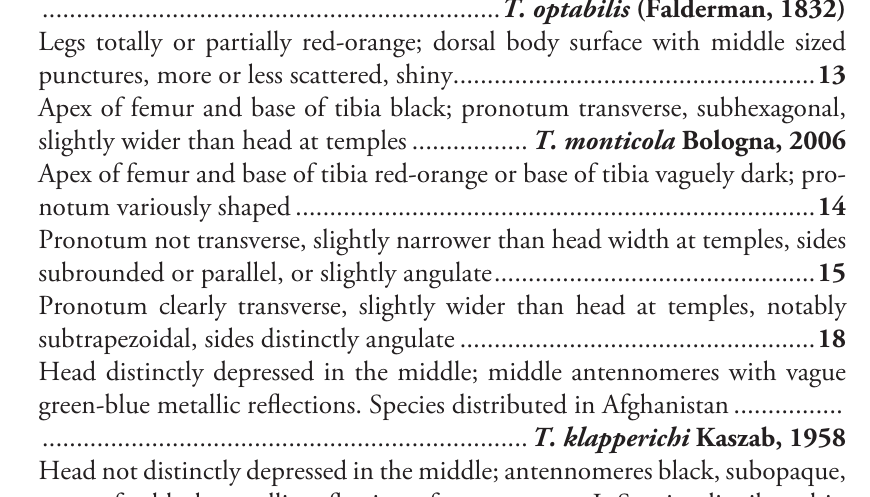
– Head not distinctly depressed in the middle; antennomeres black, subopaque, except for black metallic reflection of antennomere I. Species distributed in Pronotum with sparse punctation; pronotal sides arcuate subrounded; dorsal surface greenish-blue; head and pronotal setae mostly black, mixed with short – Pronotum with dense punctuation and in some areas subrugose; pronotal sides subparallel or slightly angulate; dorsal surface distinctly green; head and